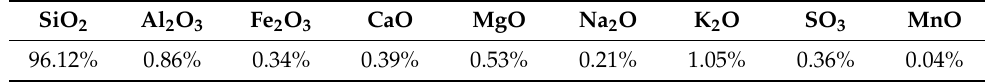
Table 3. Chemical composition of silica fume.